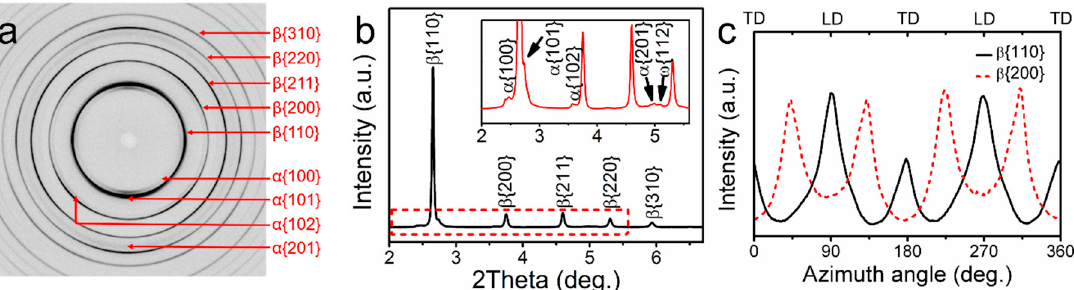
Figure 2. Structural analysis of the Ti36Nb5Zr alloy before tensile loading. ( a ) Two-dimensional SXRD pattern of the alloy. ( b ) One-dimensional SXRD spectrum integrated over the entire 360°. Inset shows the enlarged view of the boxed area in the spectrum. ( c ) Intensity distributions of the {110} β and {200} β diffraction peaks along the azimuth angle.